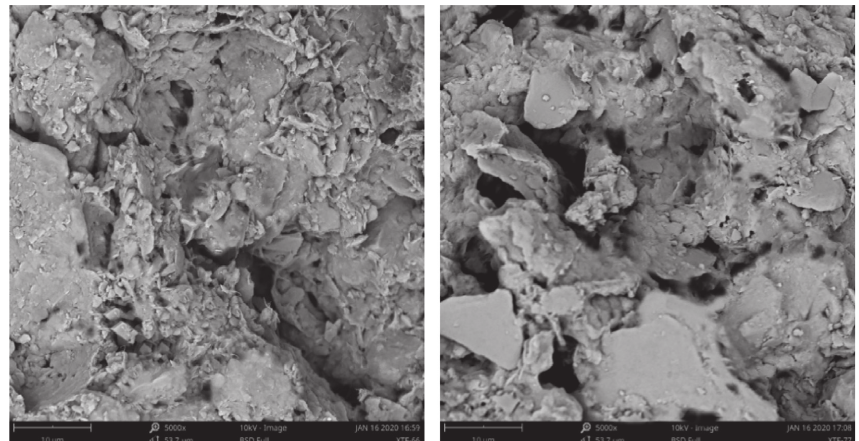
Figure 9: SEM photos of remolded